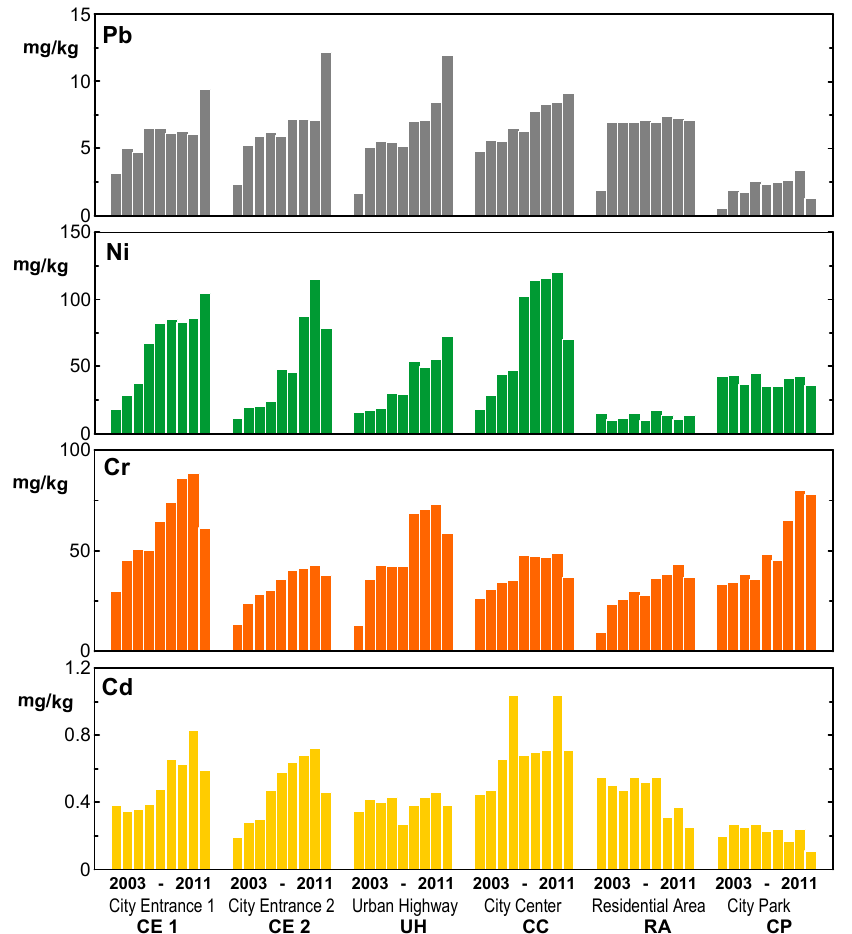
Figure 2. Metal content (Pb, Ni, Cr and Cd) in each sampled site over the years of the campaign (2003–2011).